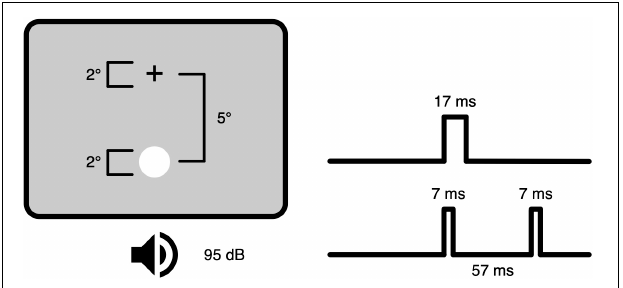
FIGURE 1 | Experimental setup in the sound-induced flash illusion. A white flash is presented below a fixation cross outside of the foveal area on a neutral background. Simultaneously, two auditory beeps are presented. The duration of the visual stimulus is 17 ms, the auditory stimuli have a duration of 7 ms with an onset asynchrony of 57